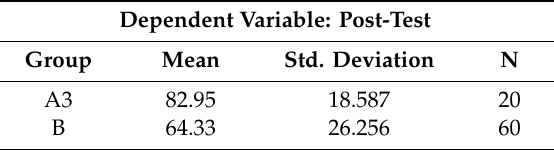
Table 6. Descriptive Statistics of groups A3 and B.